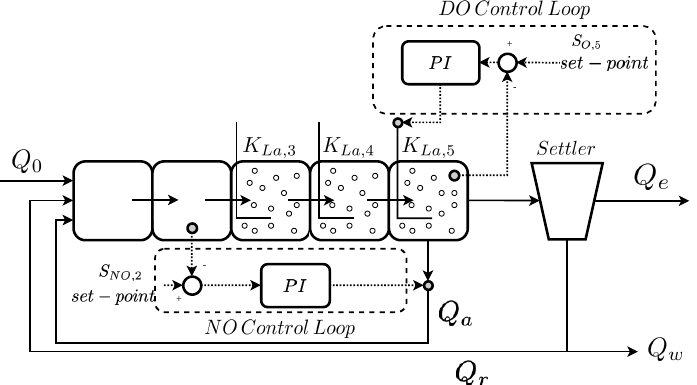
Figure 1. Benchmark Simulation Model No. 1 layout. Q o , Q a , Q r , Q e , and Q w are the influent, internal recycle, the external recycle, the effluent, and the wastage flow rates, respectively. Dotted lines correspond to control signals (measured concentrations, desired set-points and actuation signals), while solid lines correspond to process